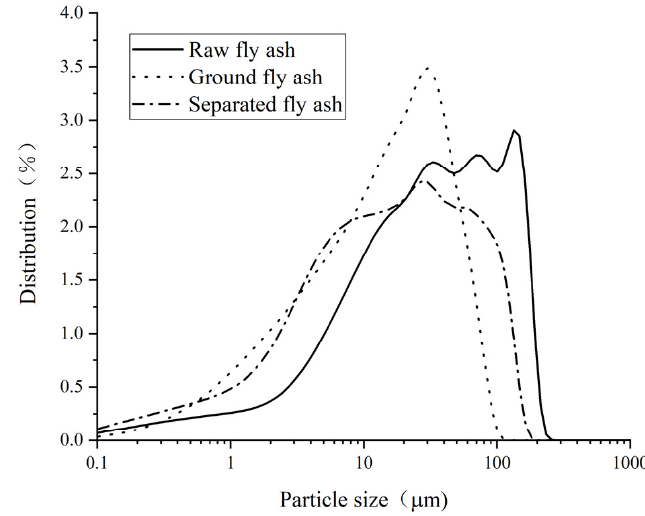
Figure 1. Particle size distribution of different fly ash. Table 3. Particle characteristic of different fly ash.